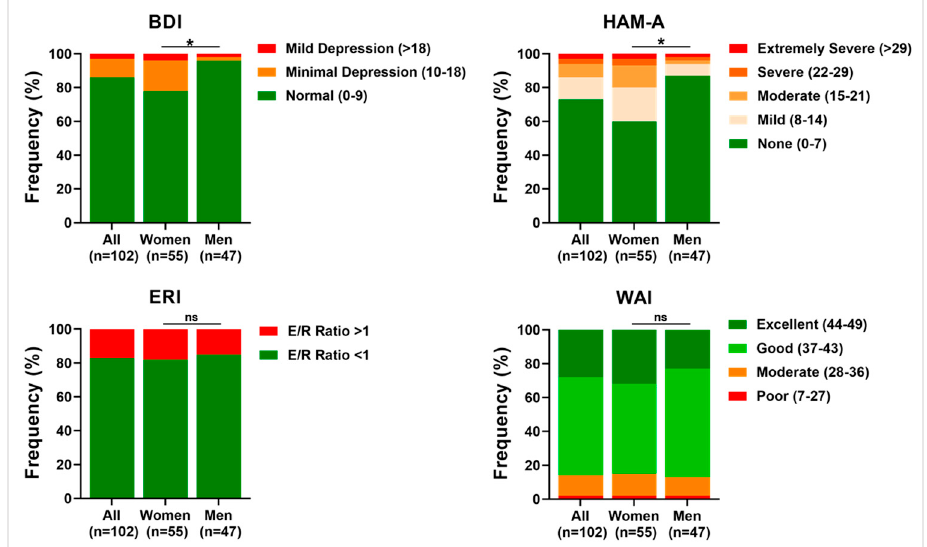
Figure 3. Distribution of relative percentage frequencies within nurses in stress-related questionnaires. The plots show the percentage distribution of the nurses for the whole population (left columns), as well as strati fi ed into women (middle columns) and men (right columns) within the four scales relative to work-related stress: Beck Depression Inventory (BDI), Hamilton Anxiety Scale (HAM-A), E ff ort Reward Imbalance (ERI), and Work Ability Index (WAI). Green indicates positive outcomes, yellow and orange indicate intermediate outcomes, and red shows negative outcomes. * p < 0.05; ns, not signi fi cant.